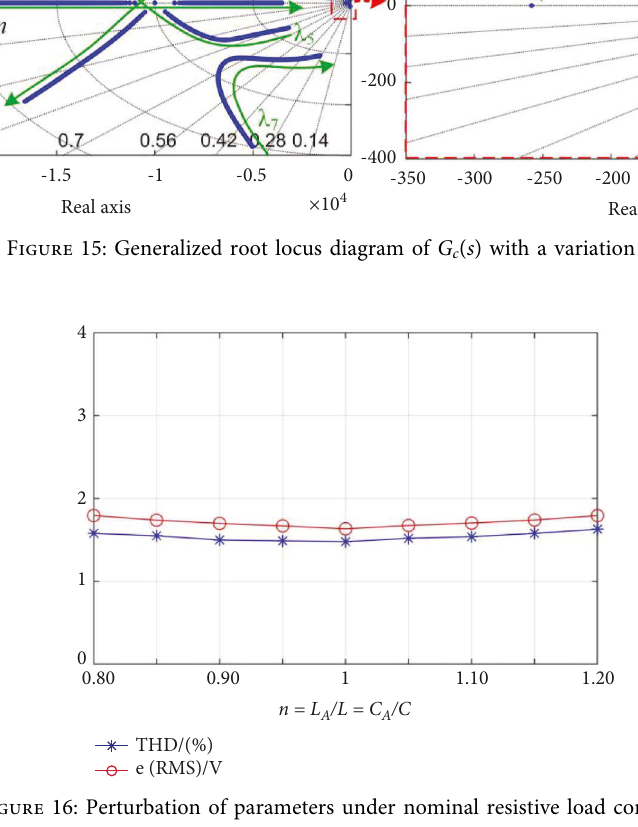
Figure 16: Perturbation of parameters under nominal resistive load conditions.